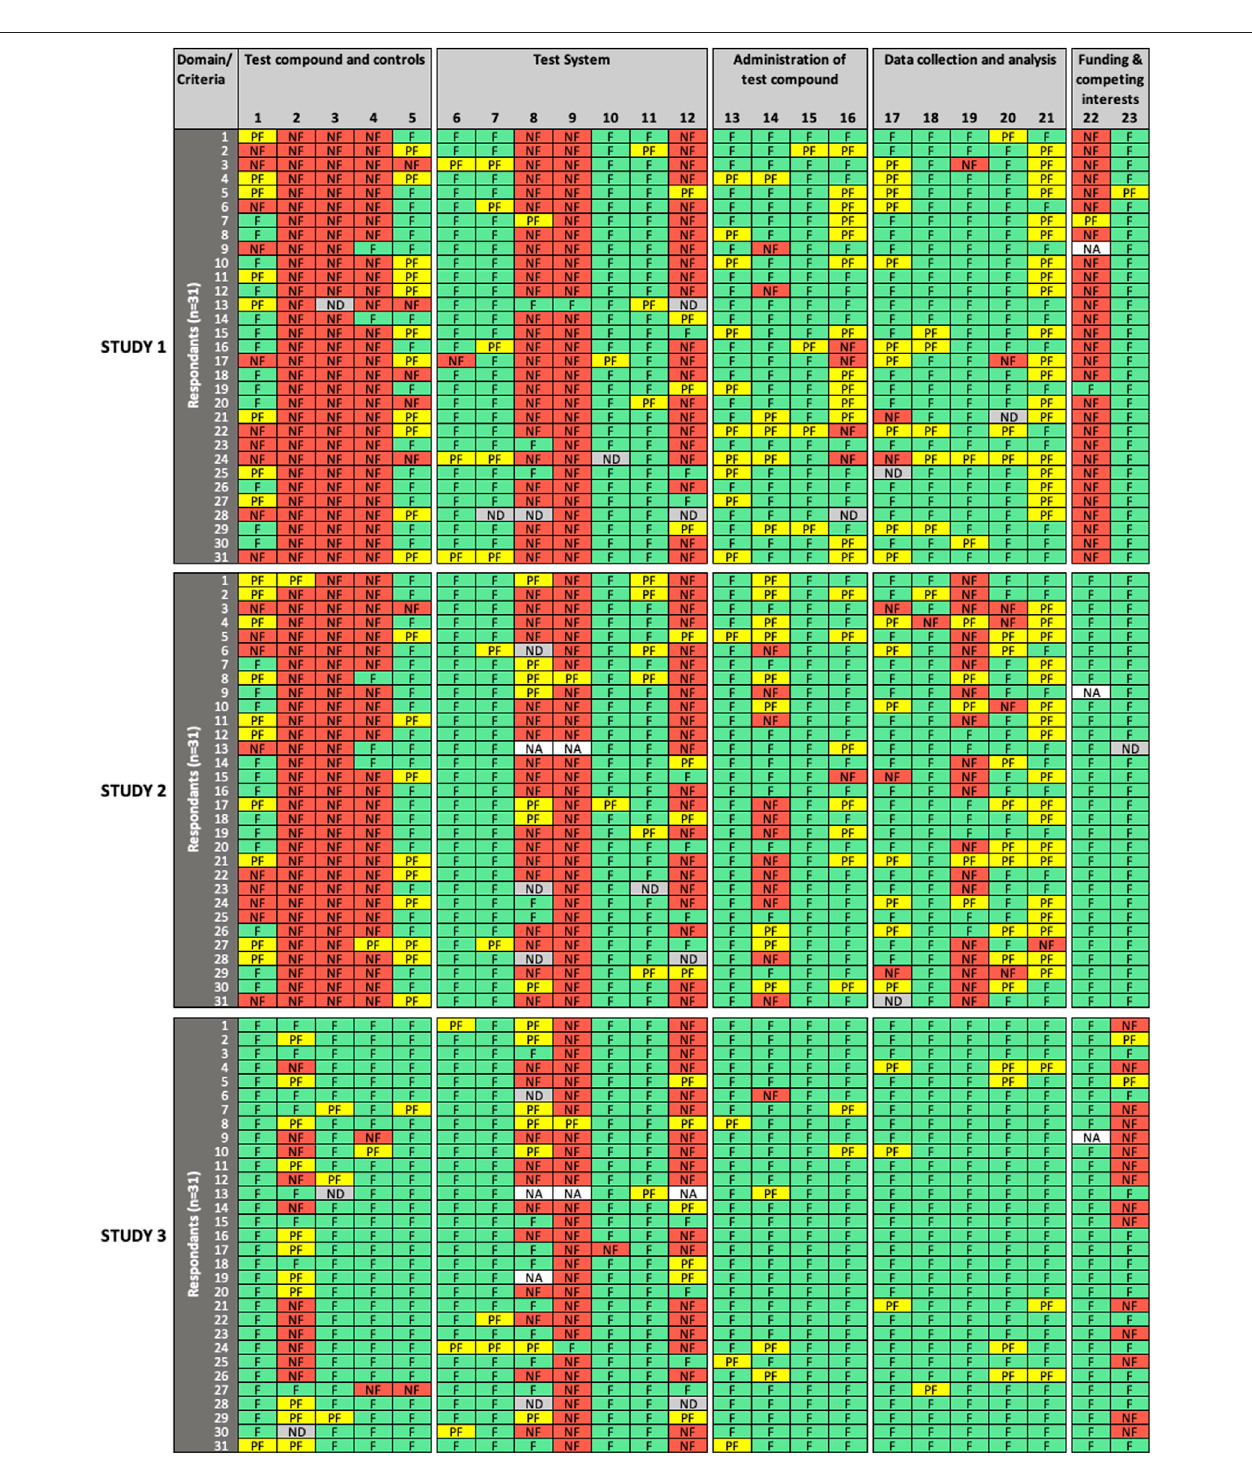
FIGURE1| Resultsoftheexperttestroundevaluationsofreportingquality (RQ) ofthethree invitro studies( n (cid:1) 31participants).Eachrowrepresentstheevaluation by one participant; columns represent individual criteria. Green cells indicate criteria judged as “ ful fi lled ” (F) , yellowcells indicate criteria judged as “ partiallyful fi lled ” (PF) , red cells indicate criteria judged as “ not ful fi lled ” (NF) , grey cells indicate criteria left as “ not determined ” (ND) , and white cells indicate criteria removed by the participant as “ not applicable ” (NA) . RQ refers to how well the study design, methodology, conduct and results have been reported.